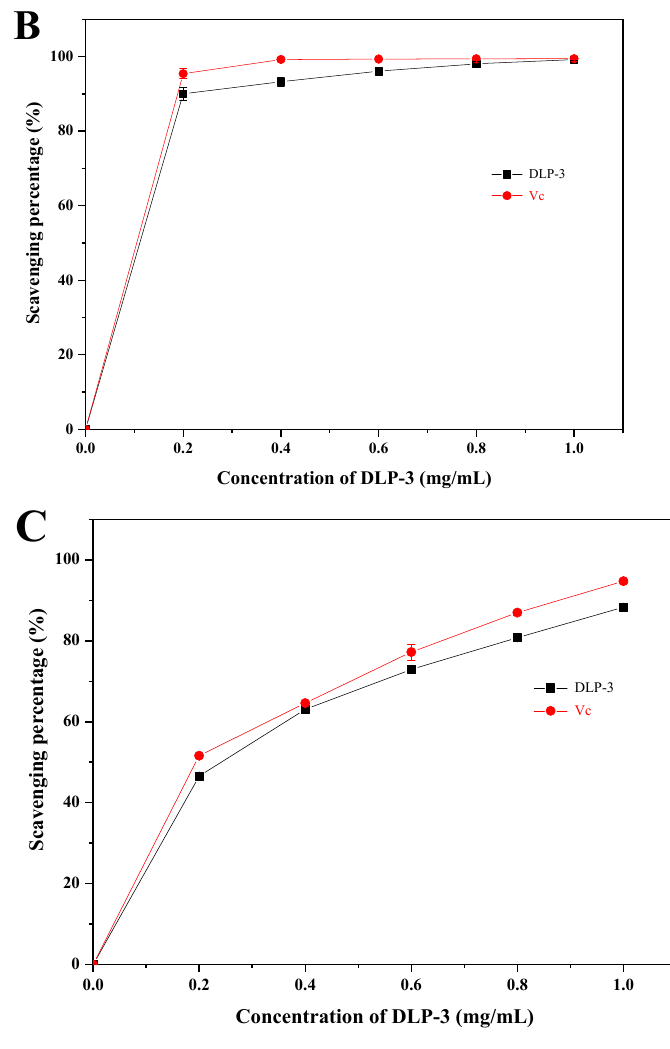
Figure 4. The antioxidant activities of DLP-3: ( A ) Superoxide radicals scavenging activity; ( B ) ABTS radical scavenging activity; ( C ) hydroxyl radical scavenging activity.